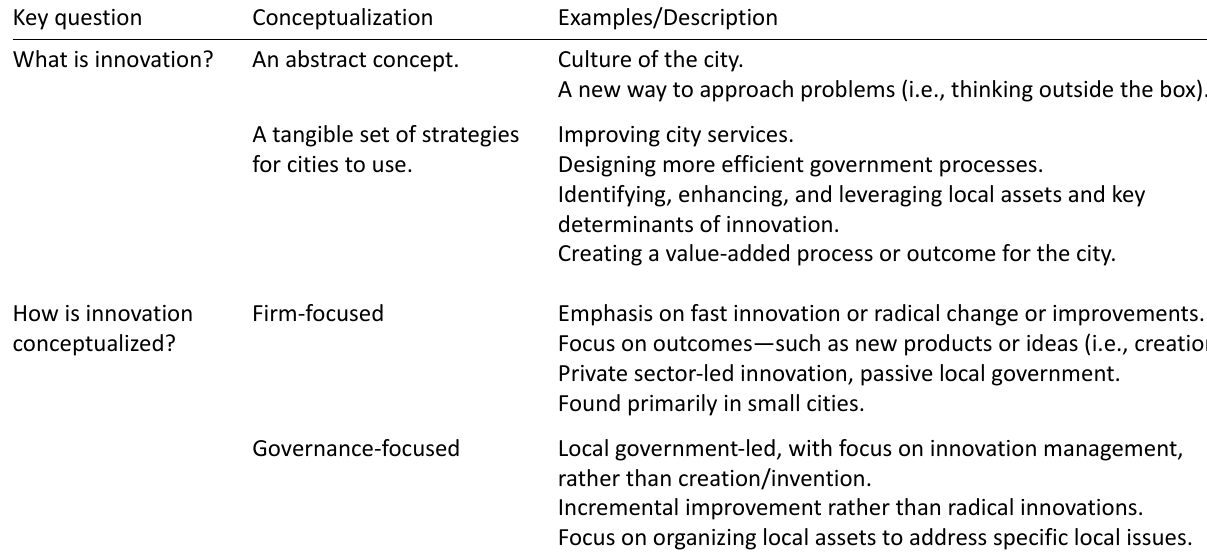
Table 2. Summary of practitioner perspectives on